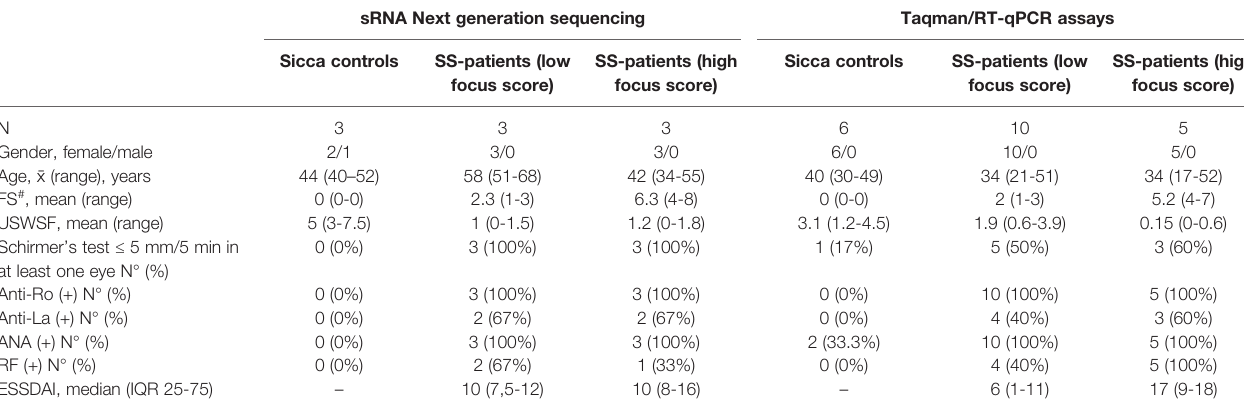
TABLE 1 | Demographic and serological characteristics of SS-patients and control